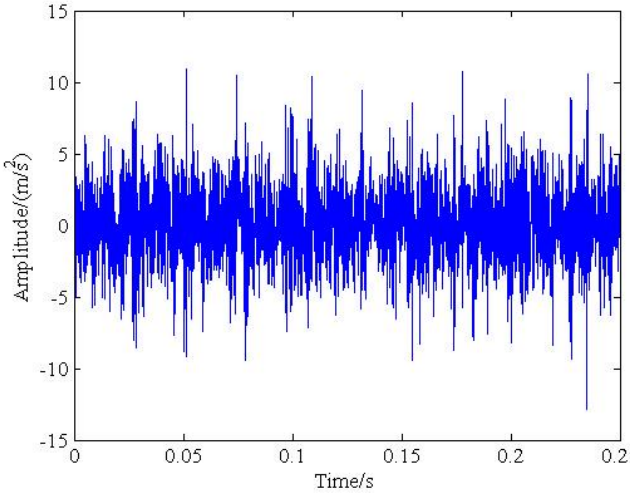
Figure 4. The measured vibration signal of bearing test rig in time ‐ domain.